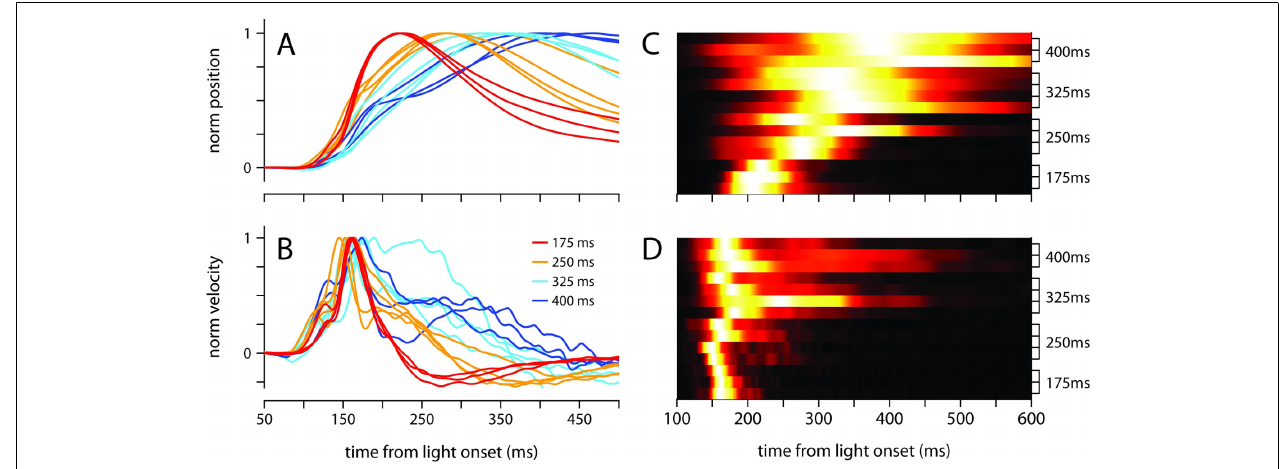
maximum eyelid closure, and (D) latency to maximum velocity. Each row of the heat map contains the probability density function for an individual mouse, with trained ISI indicated on the y -axis. For display purposes, each row is normalized to have the same maximum (white).